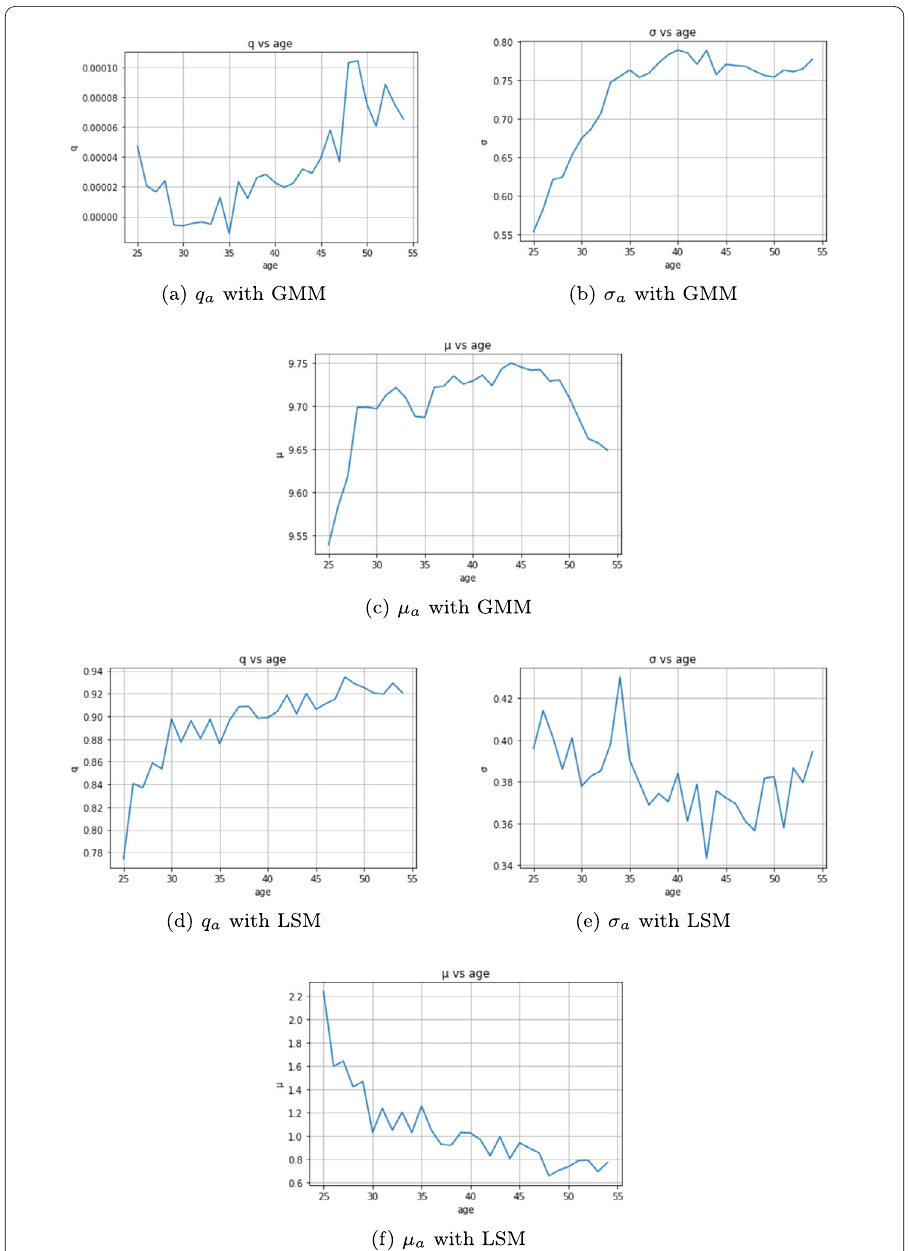
Figure 4 q a , σ a and μ a Plots for UK Labour Income, the parameters are estimated with two different methodologies of Generalized Method of Moments and Least Squares Method. The LSM utilises longitudinal data, which provides capability to estimate substantially high q values, which represent the persistence level of an individual’s income, GMM capture much lower q values, due to its incapability of utilising longitudinal